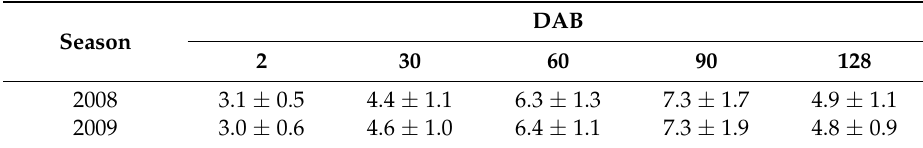
Table 2. Leaf Area Index ( LAI ) of transplanted rice at various growth stages during the 2008 and 2009 seasons (DAB—days after the basal fertilizer